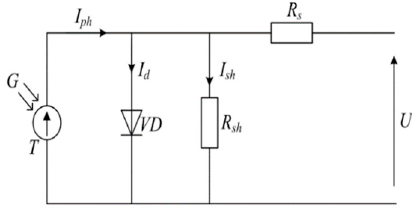
Figure 4. Equivalent circuit of photovoltaic cell.